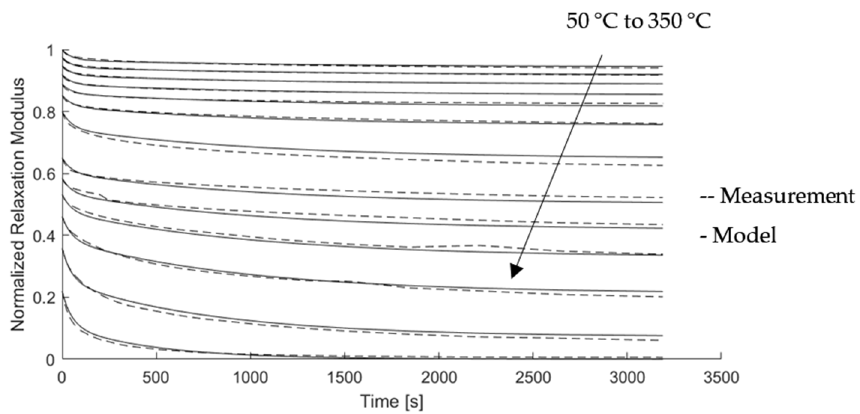
Figure 7. Comparison of the measured relaxation behavior for the developed model in the temper- ature range of 50 to 350 °C with a relaxation time of 60 min. ture range of 50 to 350 ◦ C with a relaxation time of 60